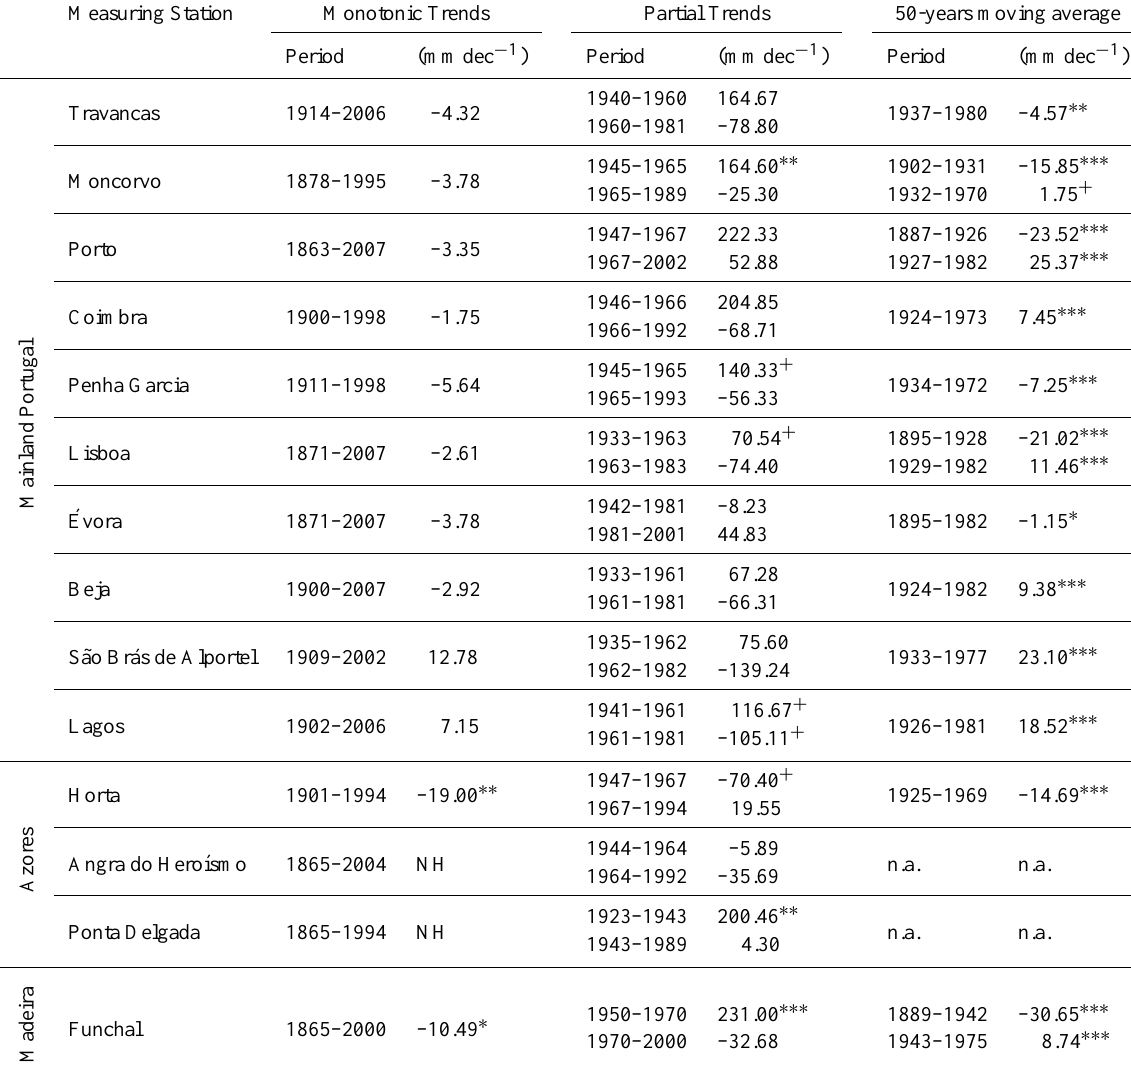
Table 3. Sen’s estimator of the slope (mmdecade − 1 ) of monotonic and partial trends of the annual precipitation, as well as for the trends in the 50-year moving average series. The confidence levels for the trend tests are marked: + 90%, ∗ 95%, ∗∗ 99% and ∗∗∗ 99.9%. The periods selected for partial trends were based on breakpoints located using the methodology described in Tom´e and Miranda (2005). The 50-year moving average series were taken to be centred on the corresponding period. NH identifies series that were not considered